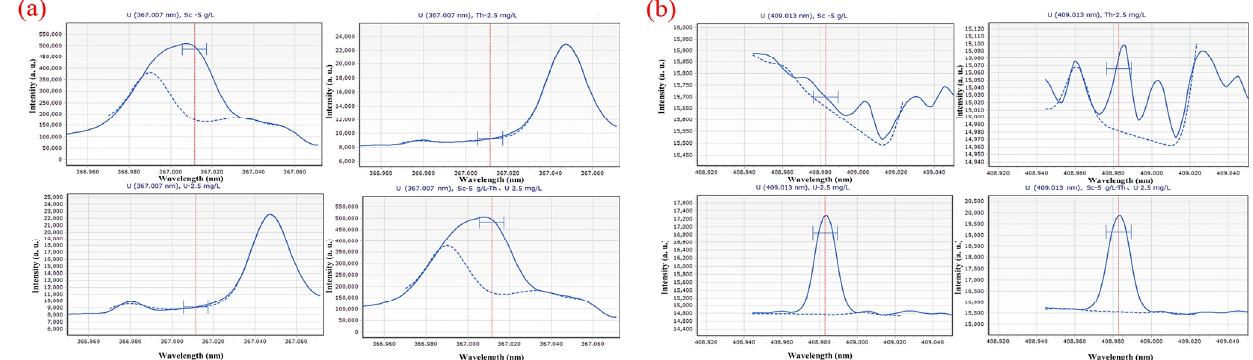
Figure 2. Scanning spectra in di ff erent solution systems (5 g·L − 1 Sc; 2.5 mg·L − 1 Th; 2.5 mg·L − 1 U; 5 g·L − 1 Sc and 2.5 mg·L − 1 Th, 2.5 mg·L − 1 U) at ( a ) 367.007 nm; ( b ) 409.013 nm wavelength.